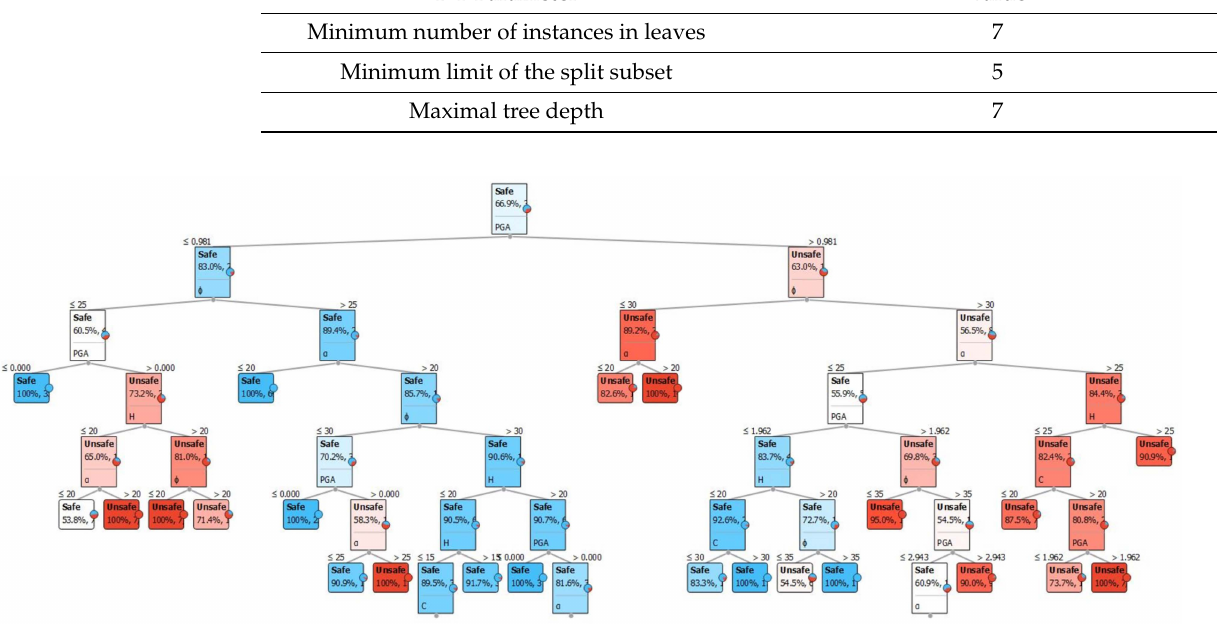
Figure 6. The optimal DT model for FOS classification.